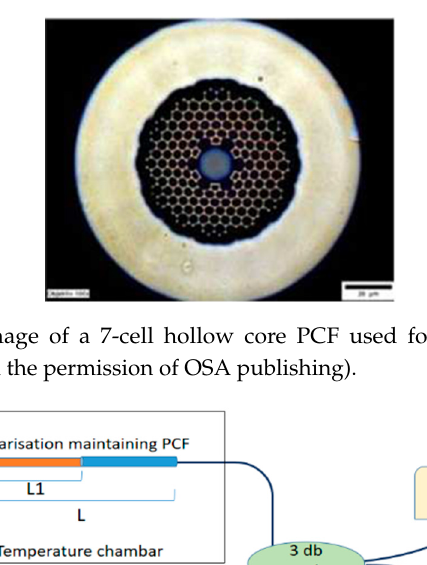
Figure 5. Microscope image of PCF-MMF spliced probe based on Quantum dot nanocoatings used for temperature sensing (Reproduced from [41], with the permission of Hindwai publishing).